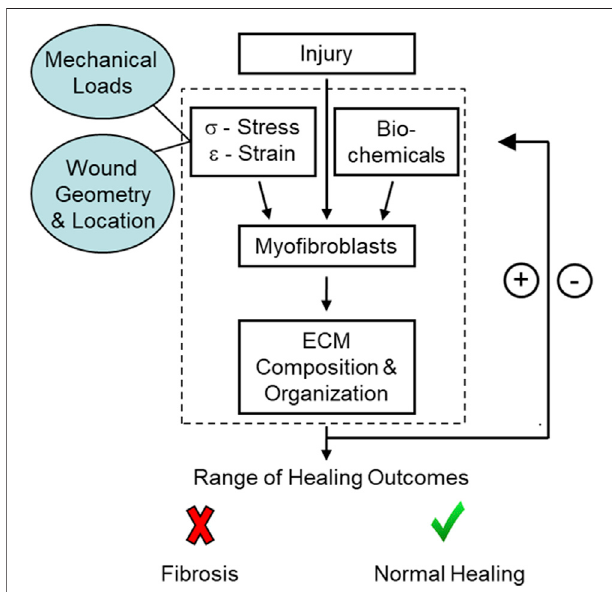
FIGURE1| Schematicofthemechano-chemicalfeedbacklooppresent during healing. Initial conditions at the site of injury, such as the location, mechanical loads, and wound geometry, can affect myo fi broblast differentiation and, in turn, healing outcomes.